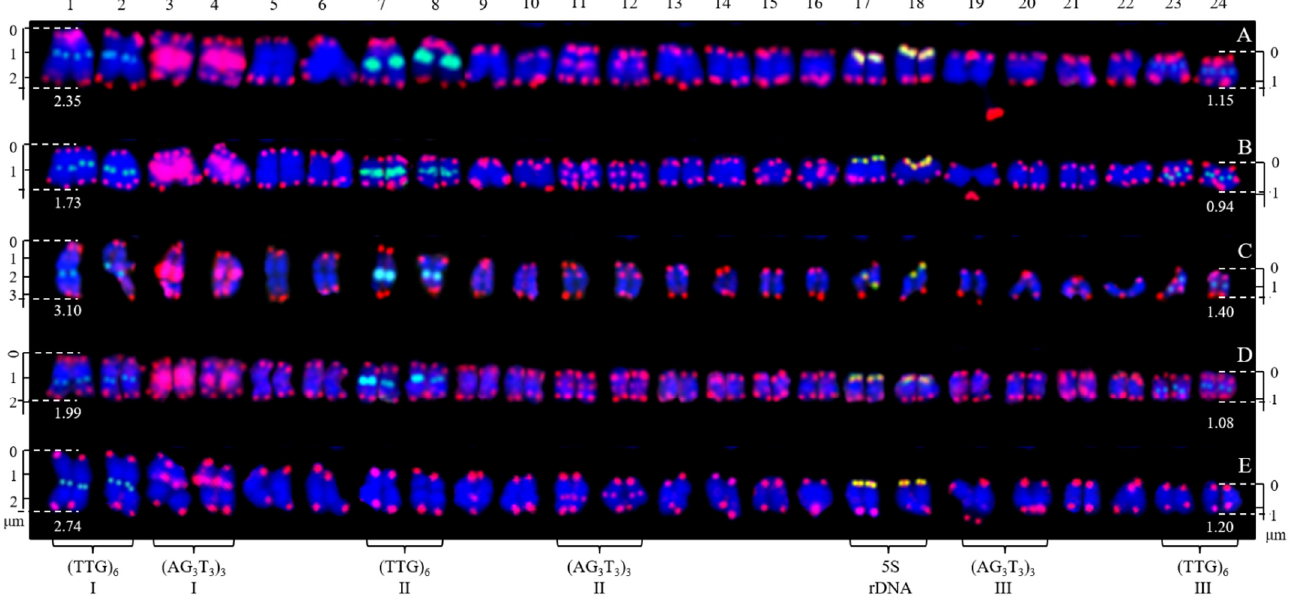
Figure 4. Chromosomes from Figure 2 presented individually. The chromosomes were aligned by a combination of length from the longest to shortest and signal pattern. The left/right number represents the chromosome length: ( A ) H. rhamnoides ‘Wucifeng’, 2.35–1.15 μ m; ( B ) H. rhamnoides ‘Shen-